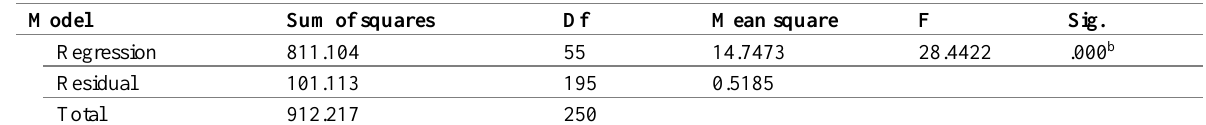
Table 2: ANOVA Findings